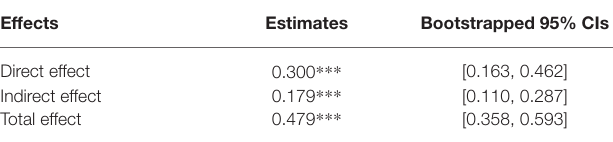
TABLE 4 | Direct, indirect and total effect of student intrinsic motivation on student creativity.